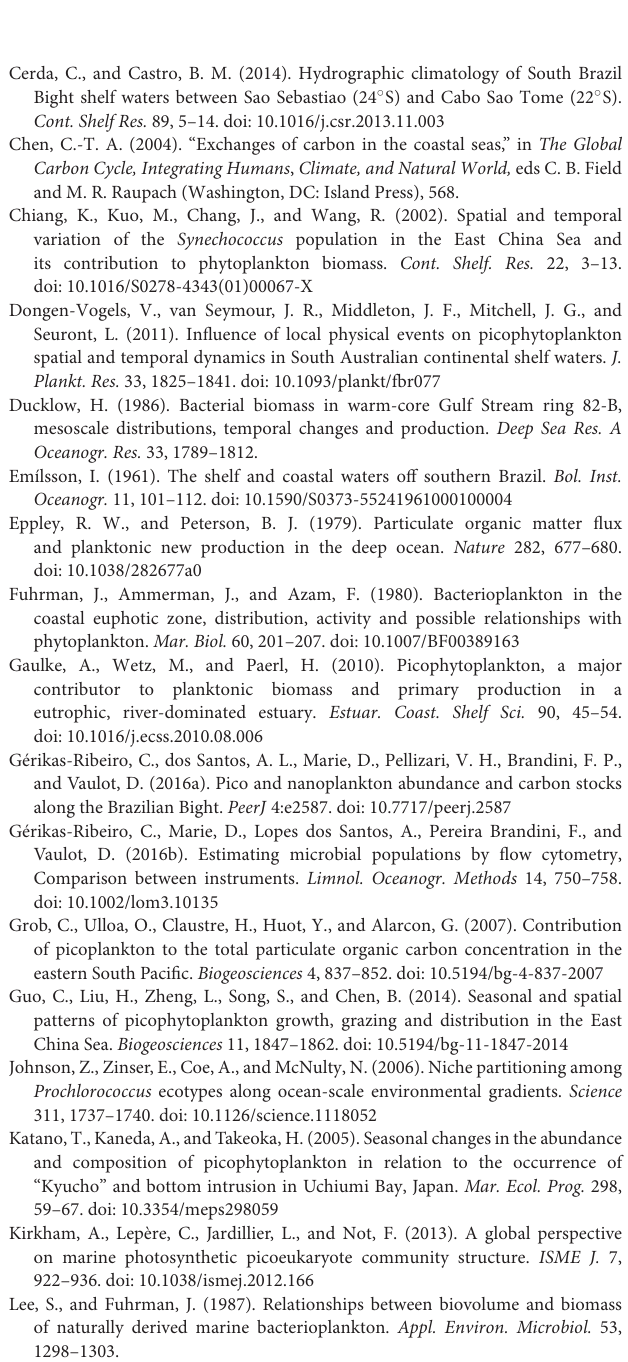
Figure S1 | Concentrations of inorganic and organic nutrients in the water column (0–250 m) along a 350 km transect: (A) Ammonia ( µ M), (B) Nitrate ( µ M), (C) Nitrite ( µ M), (D) Phosphate ( µ M), Dissolved Organic Carbon—DOC (mg.L − 1 ), Dissolved Organic Nitrogen—DON (mg.L − 1 ). Station labels are indicated at the top of each panel (38, 59, 39, 56, 40, 50, 42, 43, and 49 along the transect from the coast to the ocean). Table S1 | Environmental data, with the following information: ship station, sample number, bottom depth (m), latitude ( ◦ N), longitude ( ◦ E), sampling depth (m),